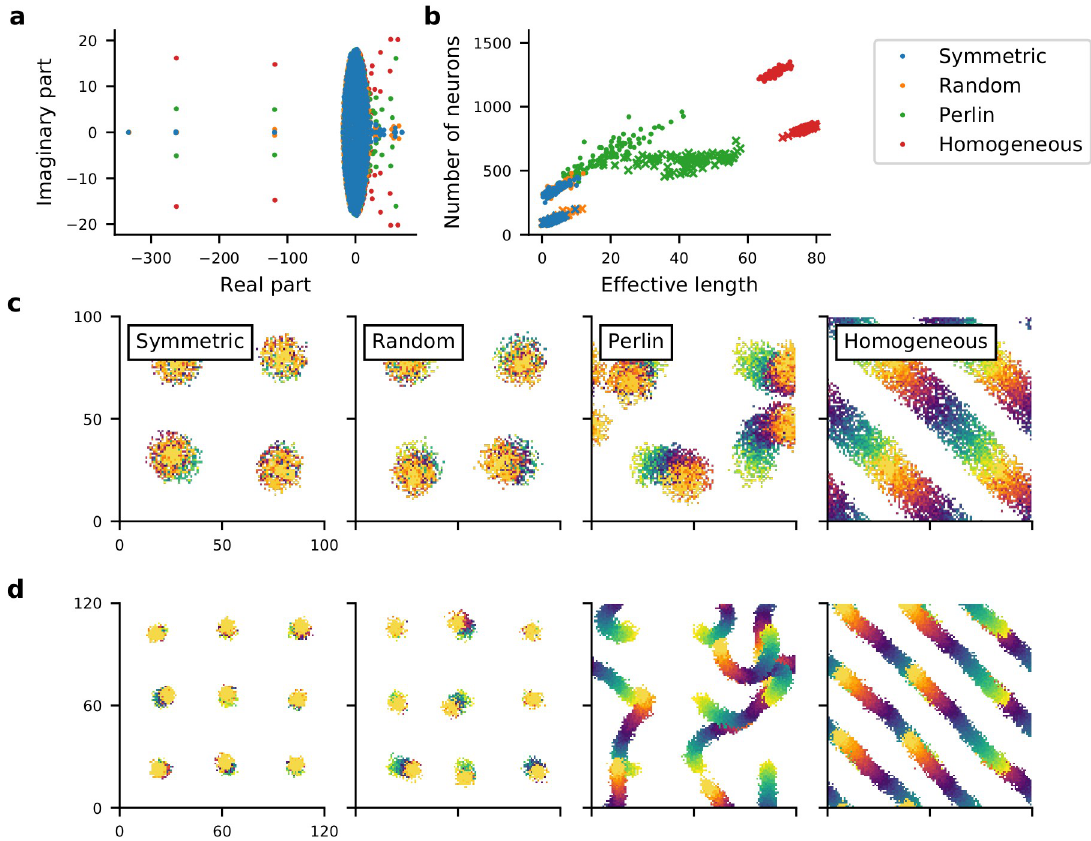
Fig 7. Spatial clustering of ϕ results in feedforward pathways in otherwise locally connected random networks. (a) The eigenvalue spectrum of the connectivity matrix of 1,000 inhibitory neurons randomly selected from symmetric (blue dots), random (orange dots), Perlin (green dots) and homogeneous (red dots) I-networks. (b) Number of unique target neurons participating in a feedforward path (y- axis) as a function of the effective length of the feedforward path (Euclidean distance between the centroids of F 1 and F 50 (see Methods). Feedforward path in I-network (dots), feedforward path in EI-network (crosses). The four colors indicate the network configurations. Note that distinctly more unique neurons with longer path length of the sequential activity movement were observed in Perlin and homogeneous configurations. (c) Effective feedforward pathways in an I-network model with the four configurations (see Methods). Feedforward paths starting from four different locations are shown. The starting neuron set F 1 is shown in yellow, the final set F 50 is shown in orange. Effective feedforward pathways were visible as trails changing color from yellow to orange. The starting neuron set F 1 consisted of 64 neurons located in an 8 × 8 region of the network. (d) Same as in c , but for an EI-network model with nine different starting set